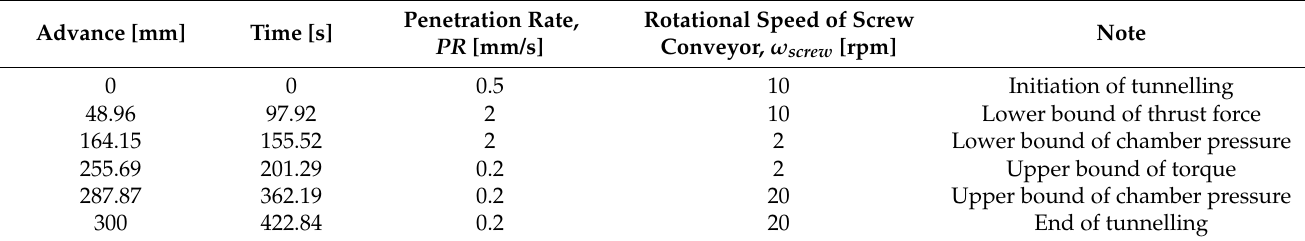
Table 7. Variation of TBM operational conditions during EPB shield tunnelling simulation (case 5).